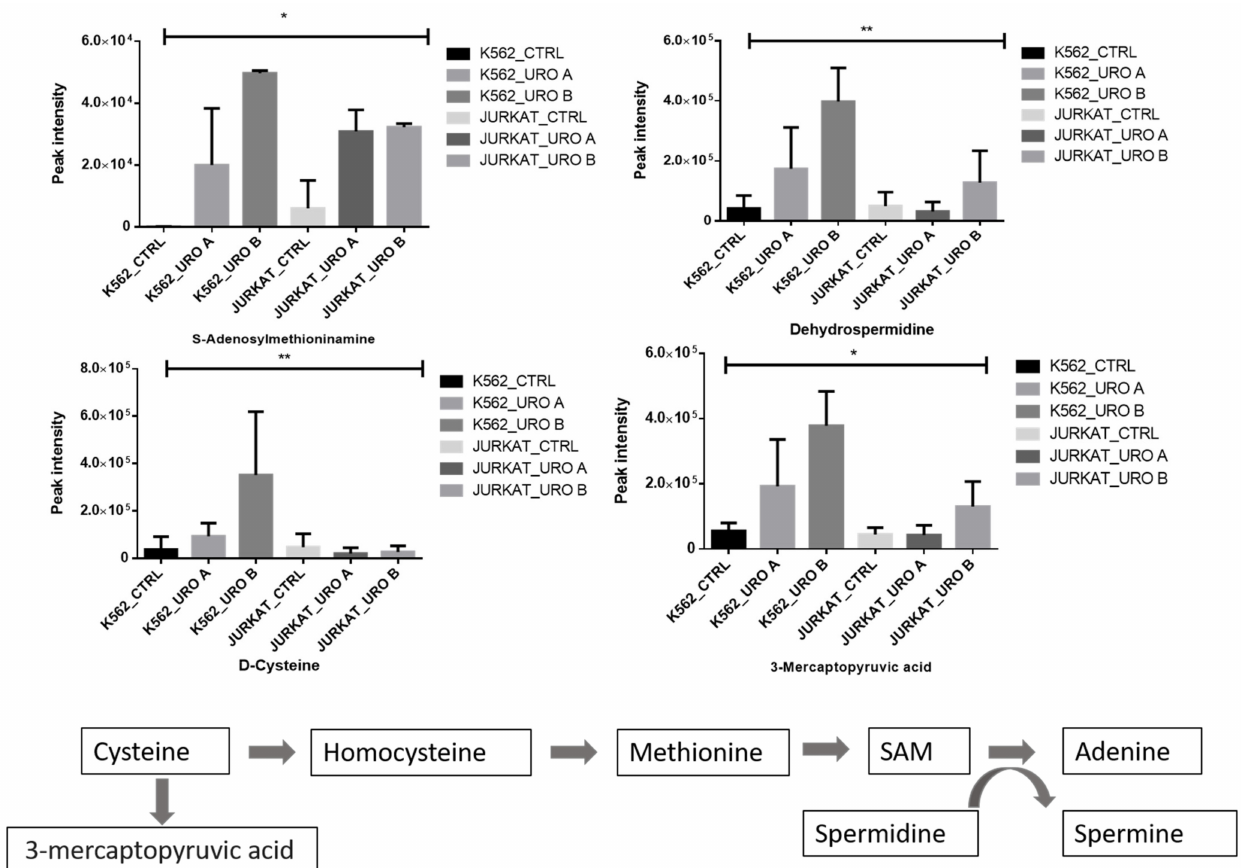
Figure 5. Urolithin A and B both modify one-carbon metabolic pathway in leukemic cells. Quantitative levels of various metabolites associated with one-carbon metabolism pathway of control and Urolithin A- and urolithin B-treated cells. * p < 0.01. ** p <